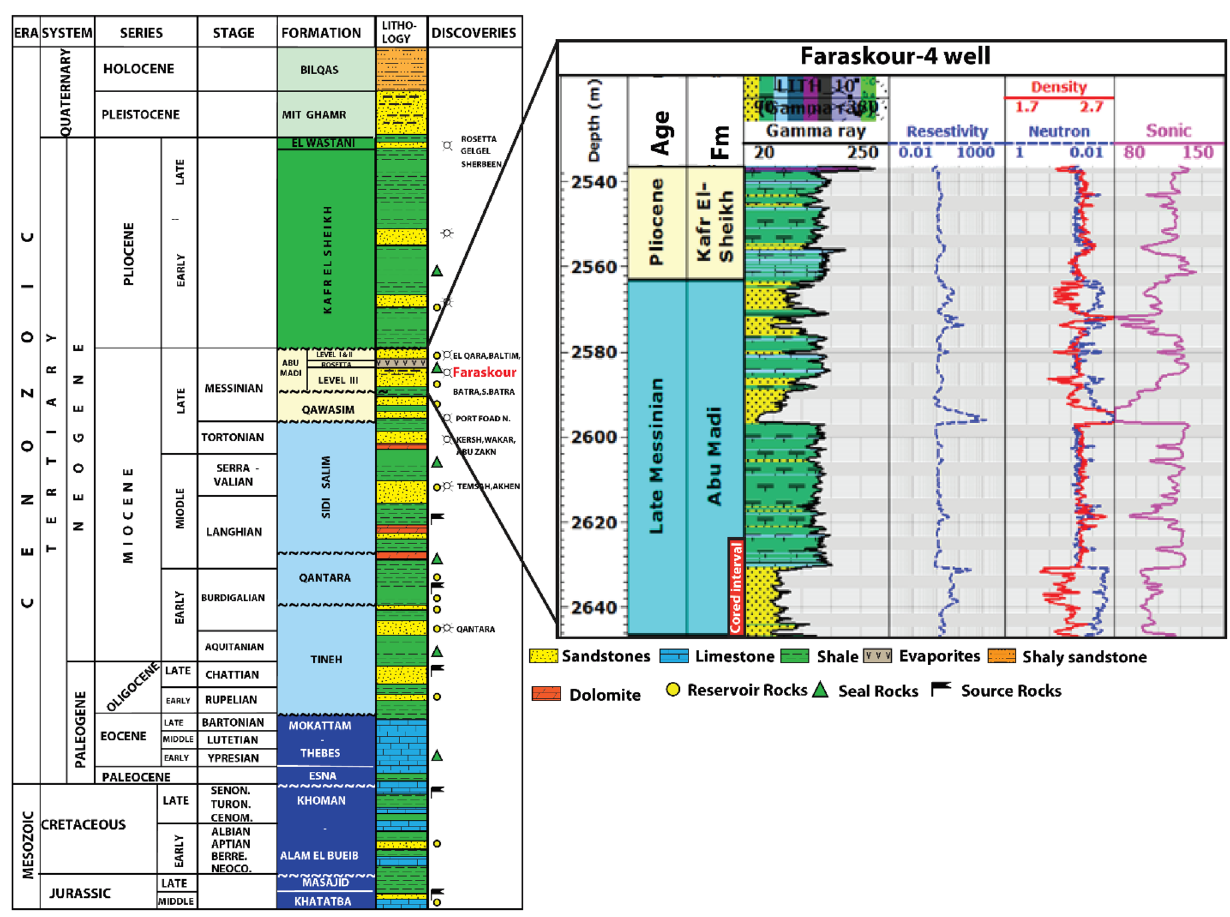
Fig. 2 Generalized lithostratigraphic column of the study area correlated with the drilled Messinian succession in Fraskour-4 well (modified after Corex